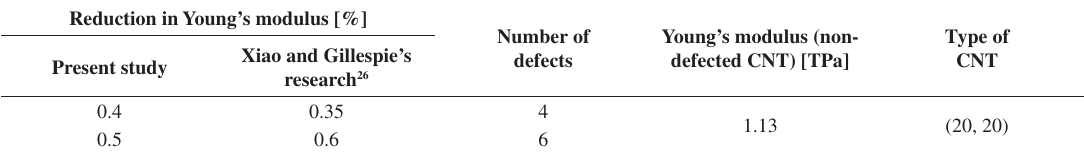
Table 4. Comparing the results of the Stone - Wales defect modeling.